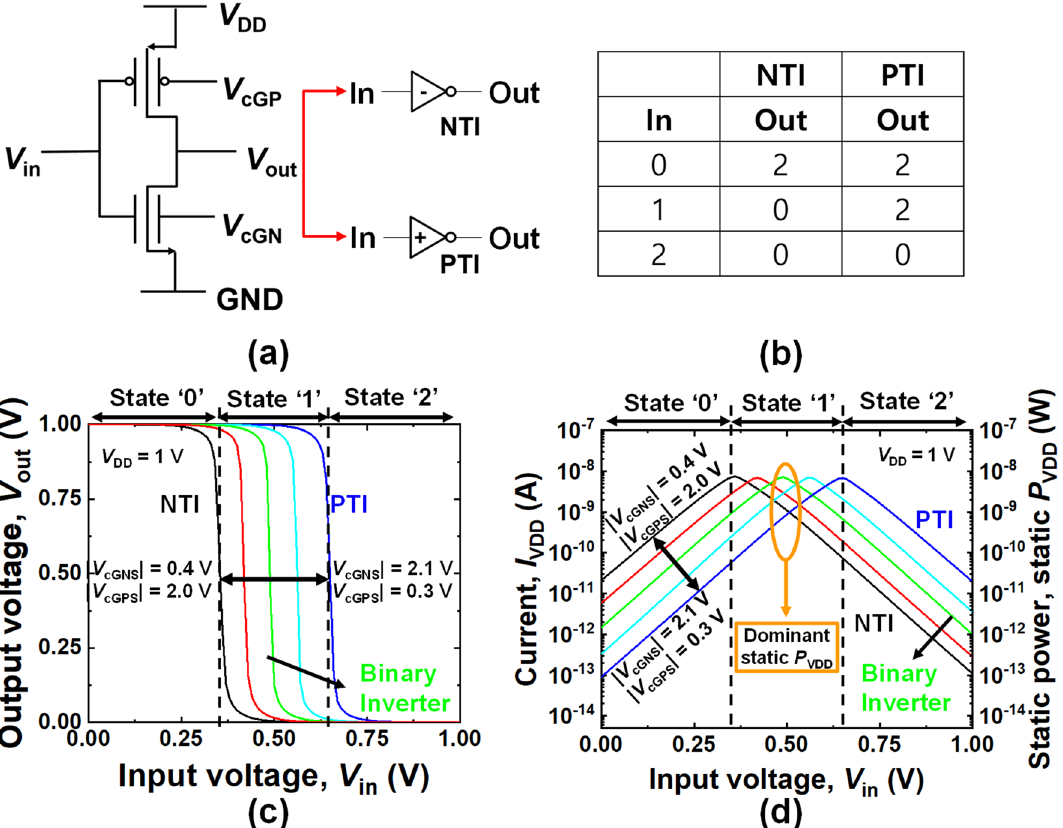
Figure 3. (a) Complementary inverter circuits composed of ICDG NMOS and PMOS with each control gate. They can serve as the NTI and the PTI by adjusting V cGN and V cGP . (b) Truth table of the NTI and PTI. (c) Input–output voltage transfer curves (VTCs) of the inverter circuit for various | V cGNS | and | V cGPS | . (d) Current ( I VDD ) from the V DD node to the ground node versus input voltage ( V in ) and power consumption ( P VDD ) versus input voltage ( V in